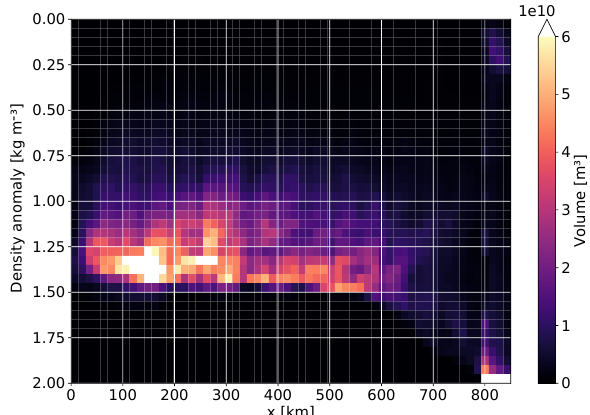
Figure 10. Histogram of tracer in the DOME test case versus the x coordinate and density class. At the mouth of the inlet ( x 800km), the inflowing waters are dense; they get entrained higher up in the density spectrum as they are being transported down- stream. The data are averaged over 1 week after day